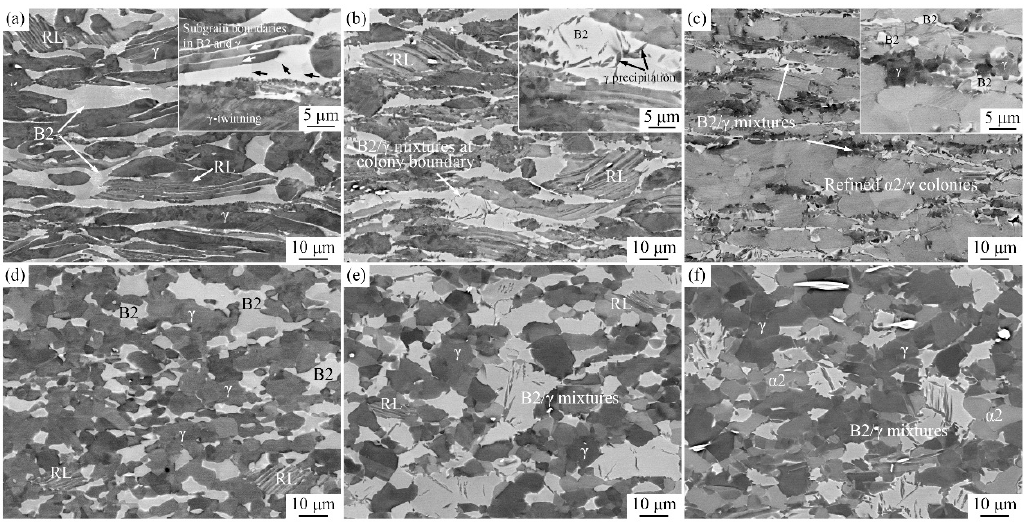
Figure 8. Microstructure of Ti-44Al-5Nb-1Mo-2V-0.2B alloy deformed at ( a ) 1050 °C/0.1 s − 1 ; ( b ) 1150 °C/0.1 s − 1 ; ( c ) 1200 °C/0.1 s − 1 ; ( d ) 1050 °C/0.001 s − 1 ; ( e ) 1150 °C/0.001 s − 1 ; ( f ) 1200 °C/0.001 s − 1 .